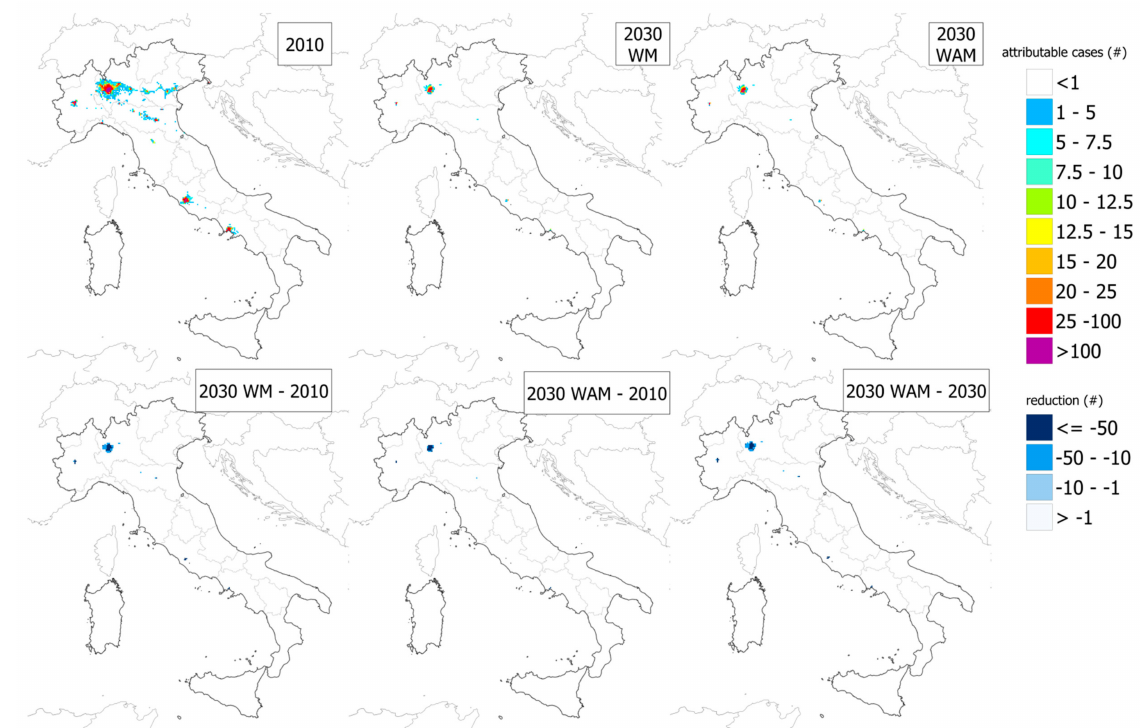
Figure 2. NO 2 mortality (number of deaths) in 2010 ( upper left ), 2030 WM ( upper center ), 2030 WAM ( upper right ), variation in mortality (as rate of reduction) between 2010 and 2030 WM ( lower left ), 2010 and 2030 WAM ( lower center ), and 2030 WM and 2030 WAM ( lower right ).